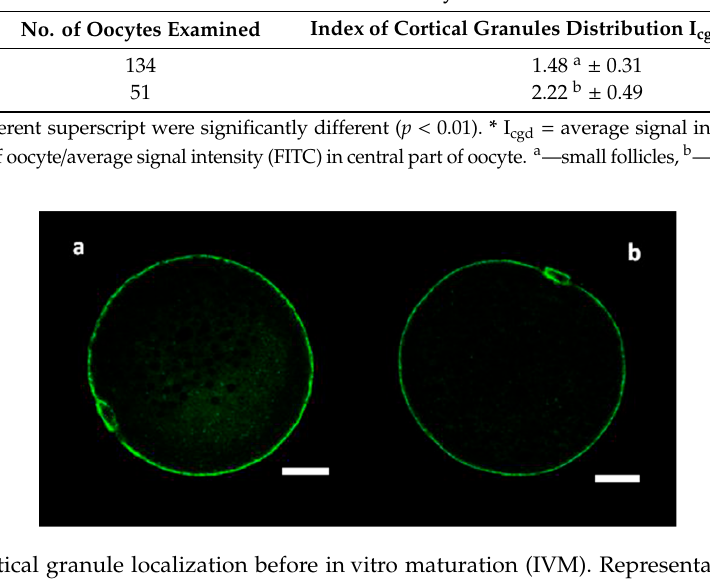
Figure 2. Cortical granule density after IVM. Representative images of porcine oocytes periphery after 44 h maturation in oocytes from small ( A ) and medium ( B ) follicles. Oocytes were stained by PNA- labeled FITC (green color—cortical granules). Scale bar represents 10 µm. The mean (±SD) of cortical granule density was significantly higher in oocytes from small follicles than in oocytes from medium follicles ( C ). 3.3. Histological Structure of Porcine Ovary and Follicles Histological analysis allowed us to evaluate the morphological structure of the collected ovaries. Ovarian follicles were observed at all stages of maturation. Clusters of primordial follicles were visible just beneath the tunica albuginea. Primary follicles are characterized by one or many layers of granulosa cells surrounding the oocyte with zona pellucida. In the secondary follicle, formation of antrum was observed between the granulosa cells. In the mature ovarian follicle, the oocyte is located on one of the poles of the follicle, and it is surrounded by cells forming a corona radiata (Figure 3).